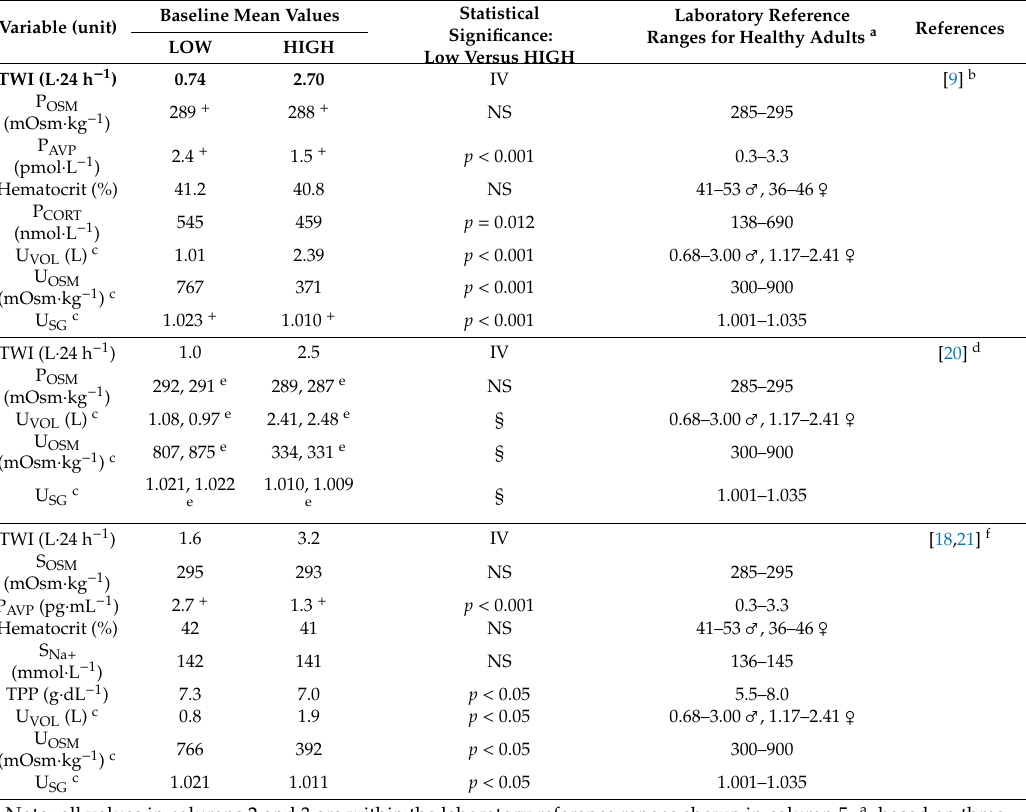
Table1. Bloodandurinecharacteristicsofhealthylowvolume(LOW)andhighvolume(HIGH)drinkers. Variable